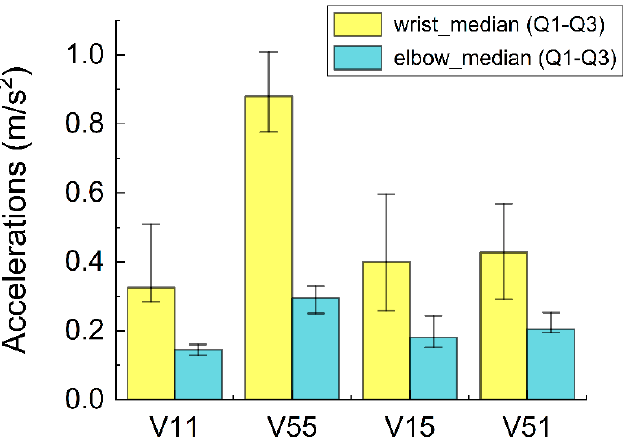
Figure 5. The median values of vibration accelerations (m/s 2 , r.m.s.) measured at subjects’ right wrists and elbows in z h -axis across four conditions with vibration applied. The upper and lower caps refer to the third quartile (Q3) and the first quartile (Q1) in each condition, respectively.